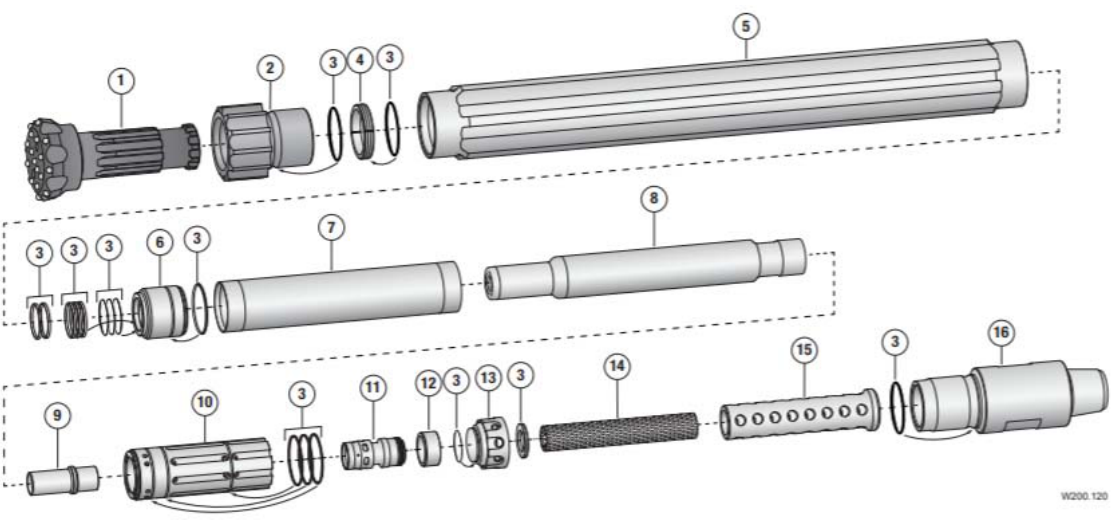
Figure 6. Wassara’s W200 DTH water-powered hammer (1—drill bit; 2—chuck; 3—seal kit; 4—bit retainer; 5—hammer case; 6—piston housing; 7—inner tube; 8—piston; 9—sliding case; 10—valve house; 11—valve; 12—sleeve; 13—guided lid; 14—filter; 15—filter support; 16—backhead API 4 ½” IF; source: wassara.com [42]).